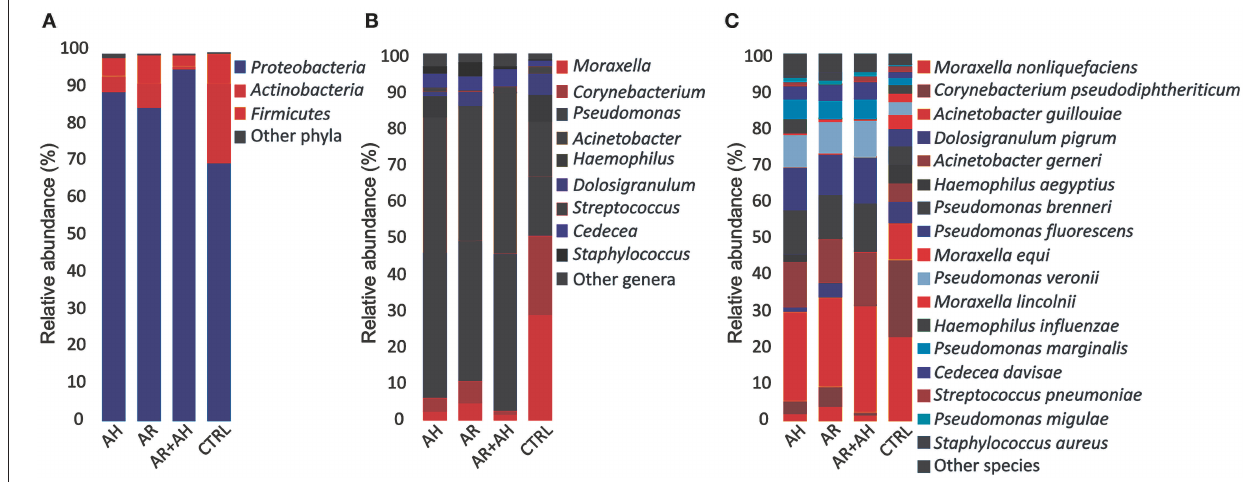
FIGURE 2 | Color-coded barplots showing the average distribution of bacterial taxa at (A) phylum, (B) genus, and (C) species levels across different phenotypes. Only taxa for which a mean relative abundance = 1% was determined in at least one group, were reported in plots. Taxa were sorted respect to the descending order of the mean relative abundances in the CTRL